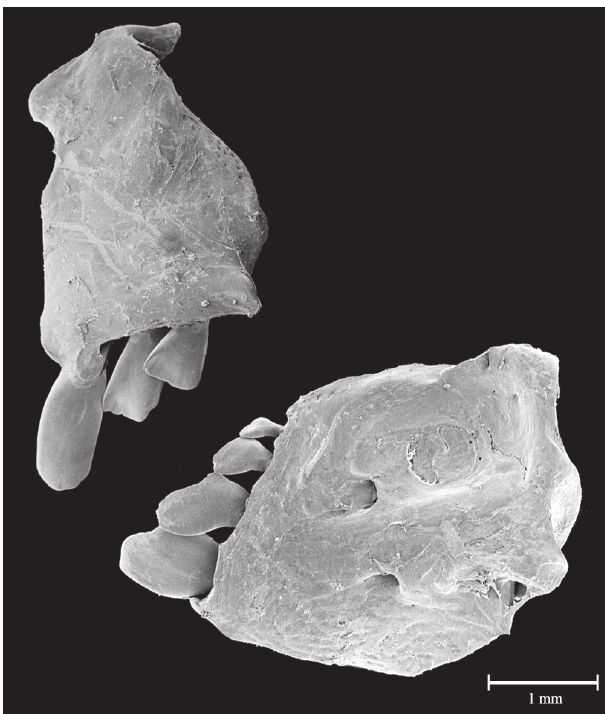
Fig. 3. Leporinus guttatus , paratype, MZUSP 96865, 96.5 mm SL. Upper and lower jaws, in frontal and lateral views